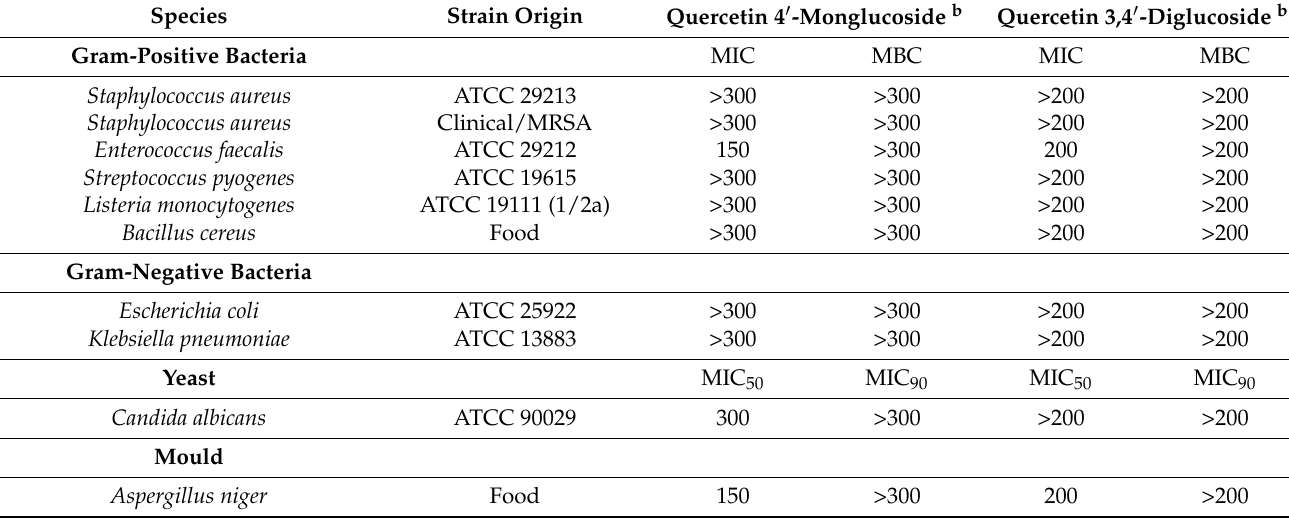
Table 4. Antimicrobial activity of quercetin 3,4 (cid:48) -diglucoside and quercetin 4 (cid:48) -monoglucoside. Species Strain Origin Quercetin 4 (cid:48) -Monglucoside b Quercetin 3,4 (cid:48) -Diglucoside b Gram-Positive Bacteria MIC ATCC